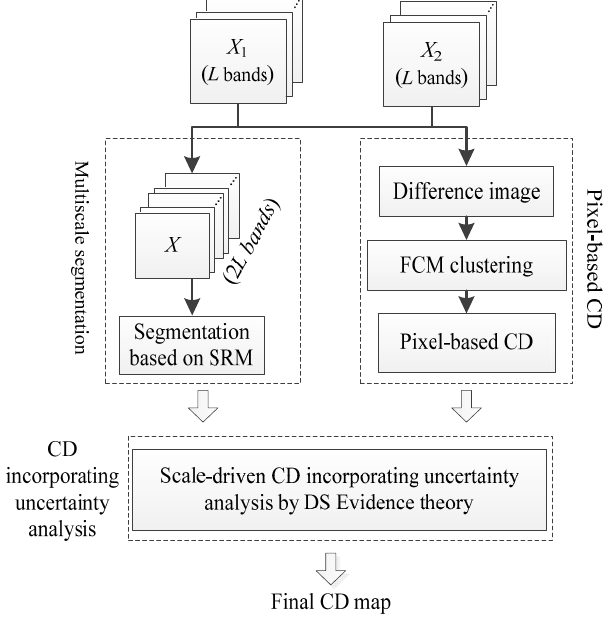
Figure 1. Flowchart of the proposed method.